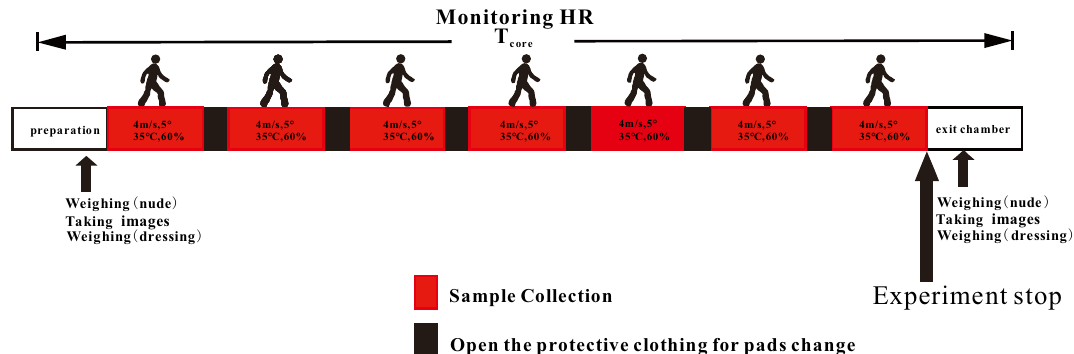
Figure 3. Schematic drawing of the trial protocol. The figure was created using Coreldraw Version (21.0.0.593).